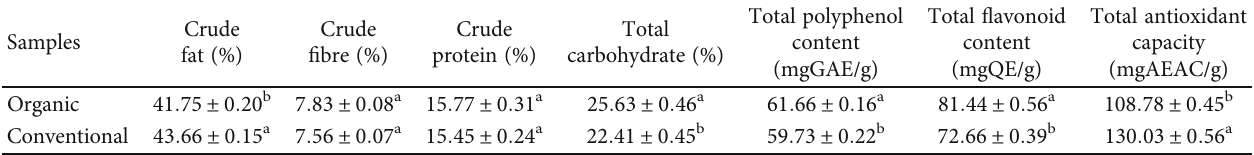
Table 1: Proximate compositions (g/100 g) and phytonutrient contents for organic and conventional cocoa samples ( mean ± SD ). Samples